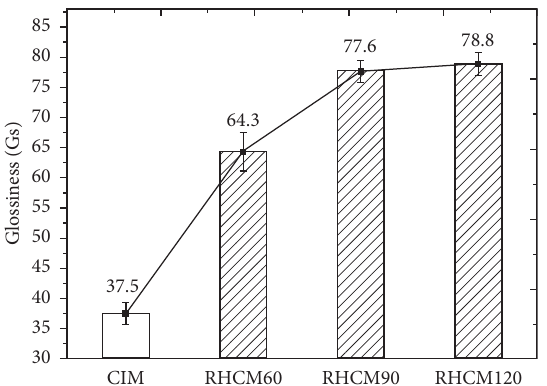
Figure 13: Glossiness variance trends of samples molded at different cavity surface temperatures.